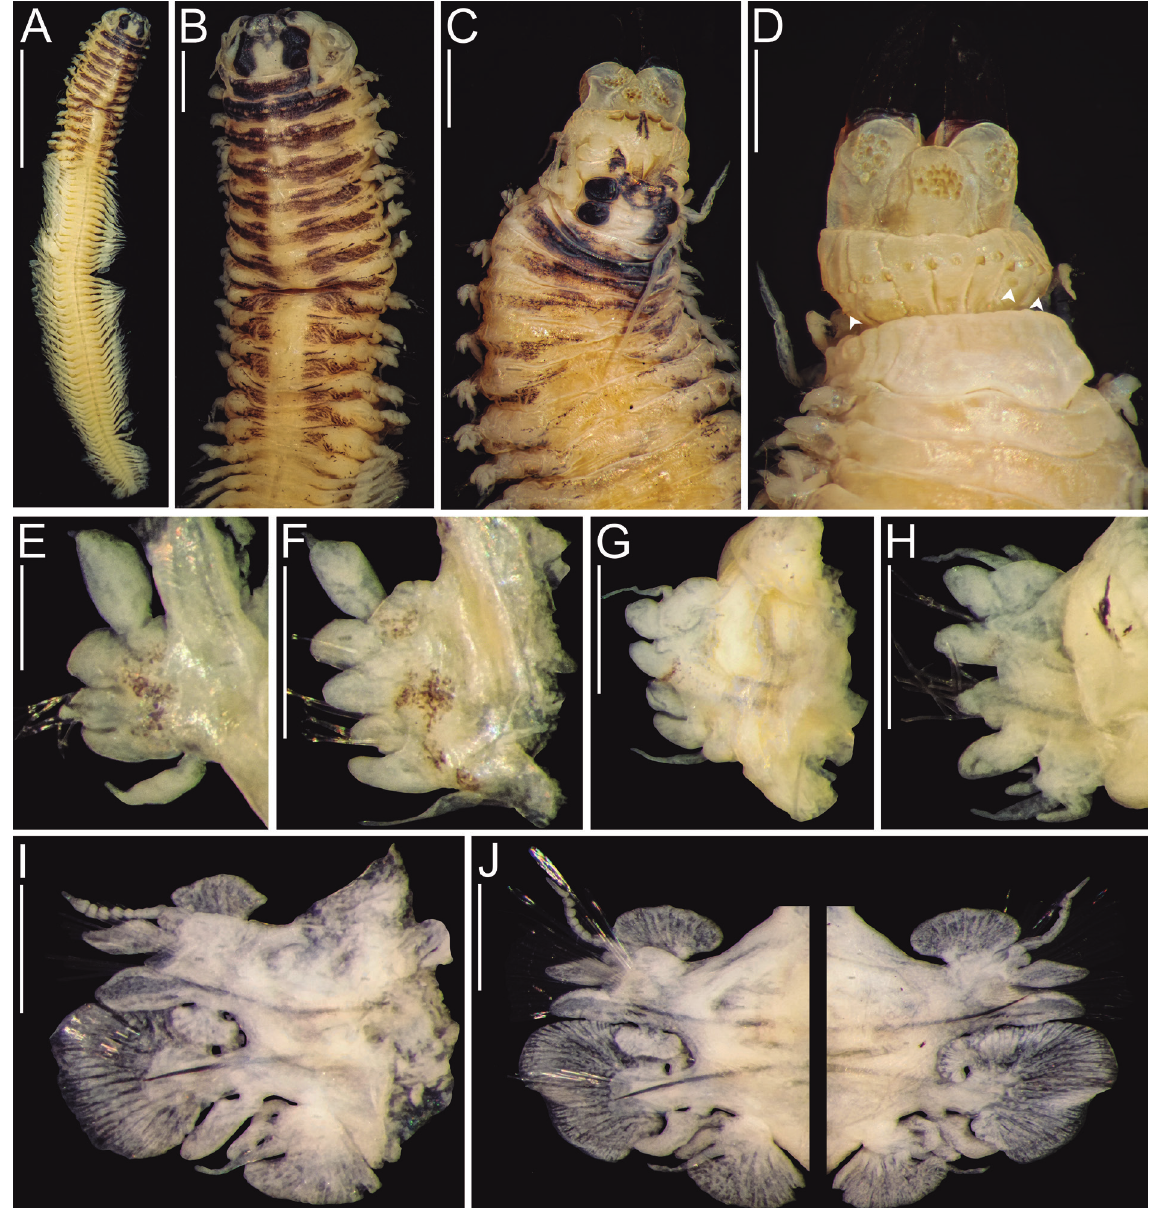
Fig. 12. Perinereis cariboea De León-González & Solís-Weiss, 1998. Non-types (ECOSUR P3209). A . Whole specimen, dorsal view. B . Anterior end, dorsal view. C . Anterior end, dorsal view. D . Same, ventral view. E . Chaetiger 2, right parapodium. F . Chaetiger 6, right parapodium. G . Chaetiger 12, right parapodium. H . Chaetiger 14, right parapodium. I . Chaetiger 18, right parapodium. J . Chaetiger 35, right parapodium in anterior (left) and posterior (right) views. Scale bars: A = 5 mm; B–D = 1 mm; E = 0.25 mm; F–J = 0.5